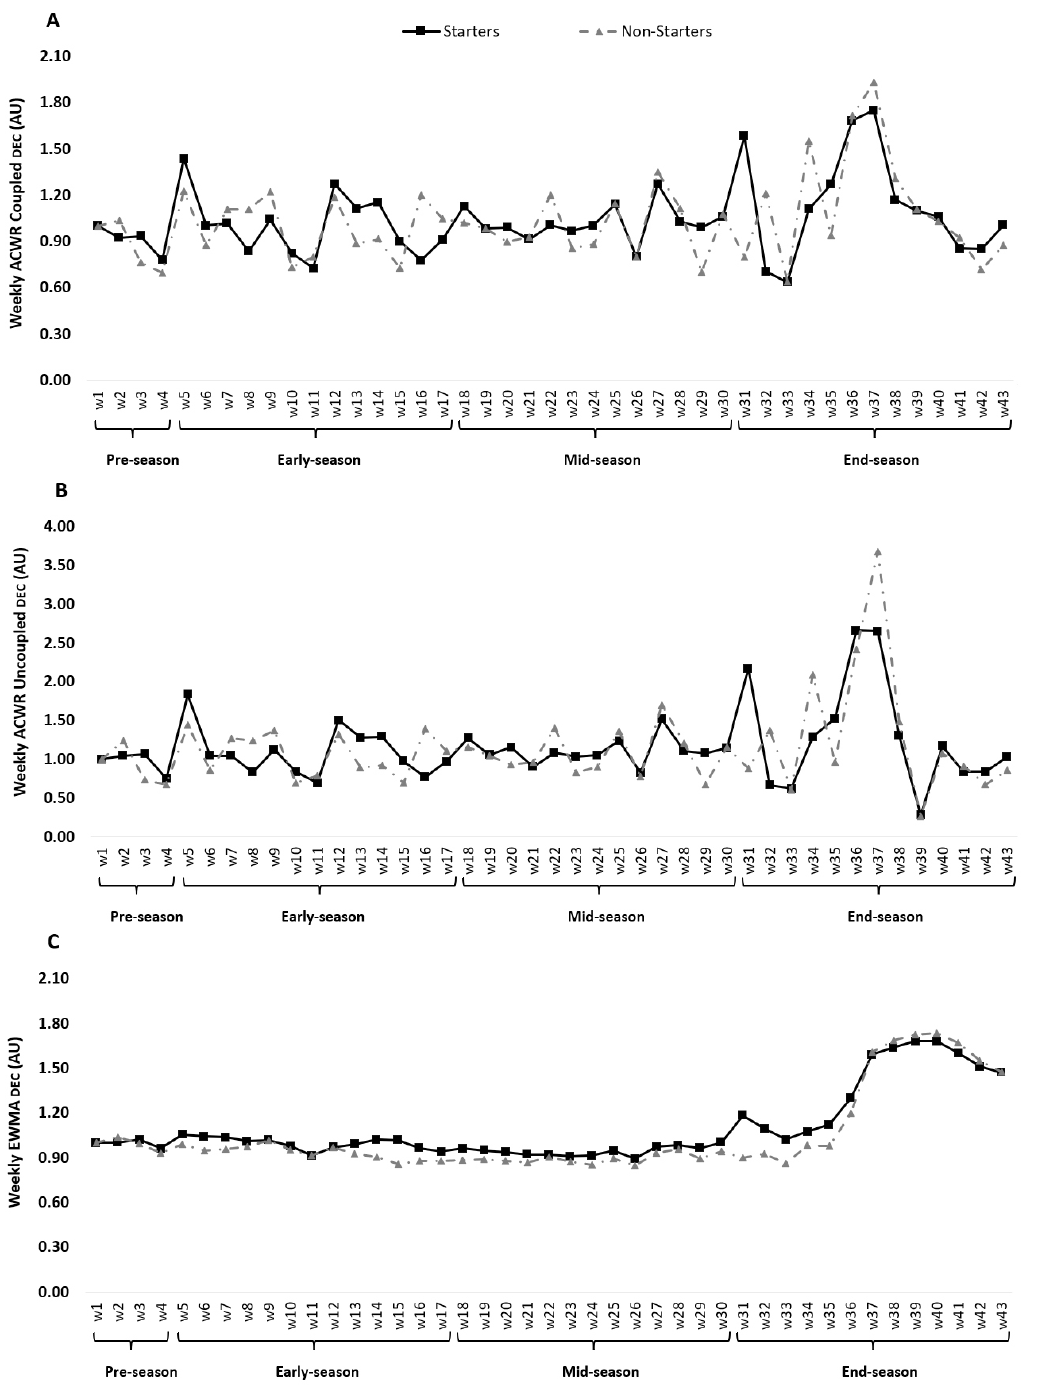
Fig. 4. ACWR coupled (A), ACWR uncoupled (B), and EWMA (C) variations calculated based on Dec across 43 weeks for starters and